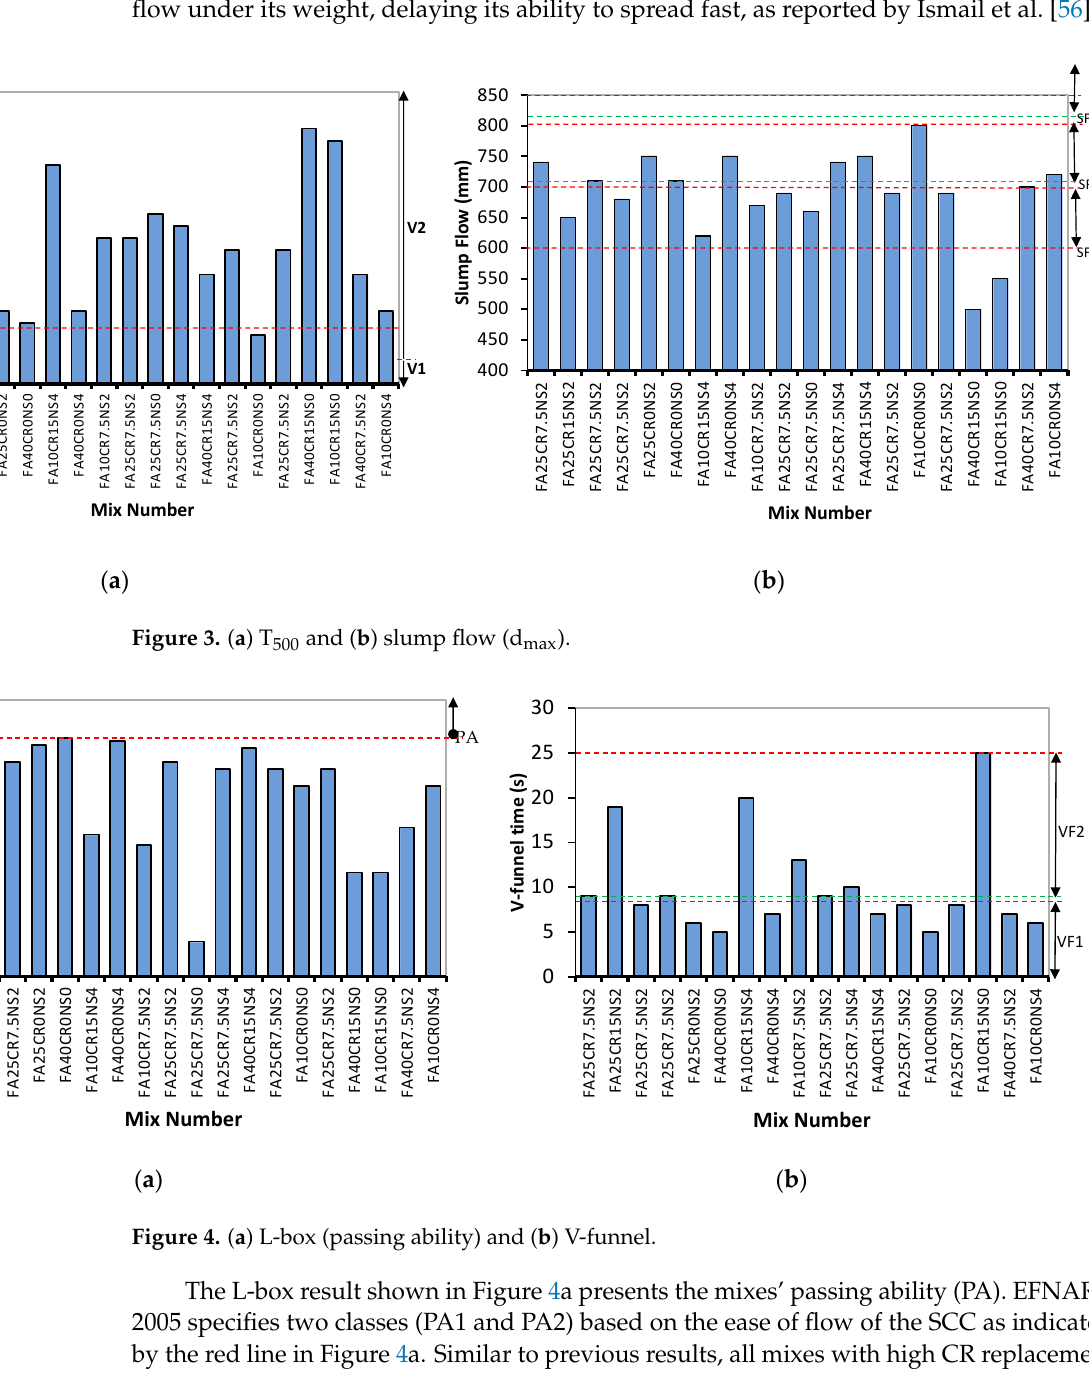
Figure 5. Slump flow for ( a ) mix FA25CR7.5NS0 and ( b ) mix FA10CR15NS0.